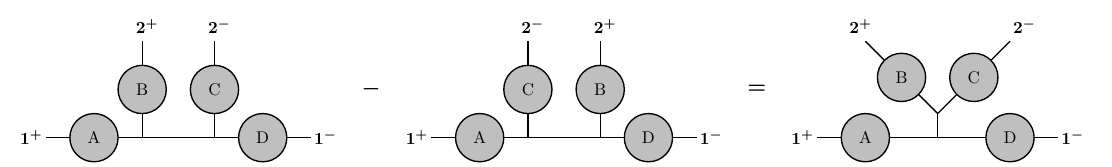
Figure 11 . One class of Jacobi relations between trivalent diagrams at two loops. The ‘blobs’ (A, B, C, D) are trivalent trees where we suppress the n external legs. On the left-hand side, the diagrams contain a single quadratic propagator each, of the type 1 = ( ‘ 1 + ‘ 2 + K ) 2 in the (cid:12)rst case and 1 = ( ‘ 1 (cid:0) ‘ 2 + K ) 2 in the second case. On the right-hand side, the diagram has independent loops, and therefore possesses no propagator involving both loop momenta.